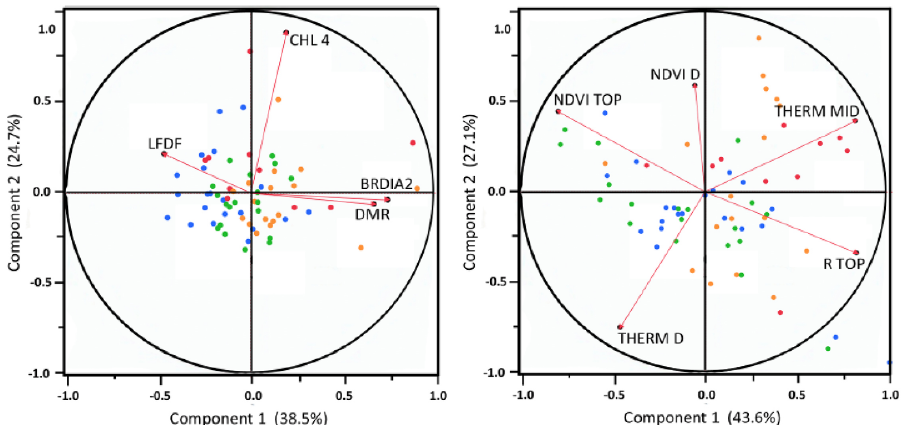
Figure 4. Loading for the first four principal components for morphological traits ( left ) and spectral traits ( right ). Principal components analysis (PCA) cumulative variation explained for the first two axes was 63% for morphological, and 71% for spectral traits.